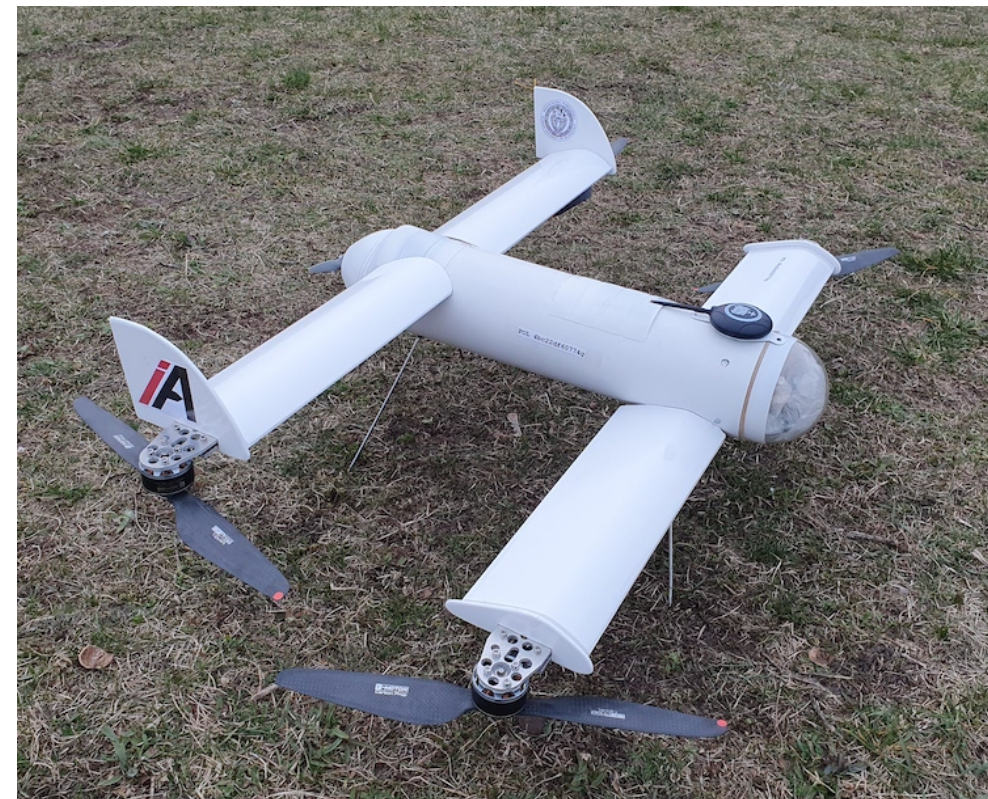
Figure 1. The Elka1Q—an experimental tandem-wing quadplane